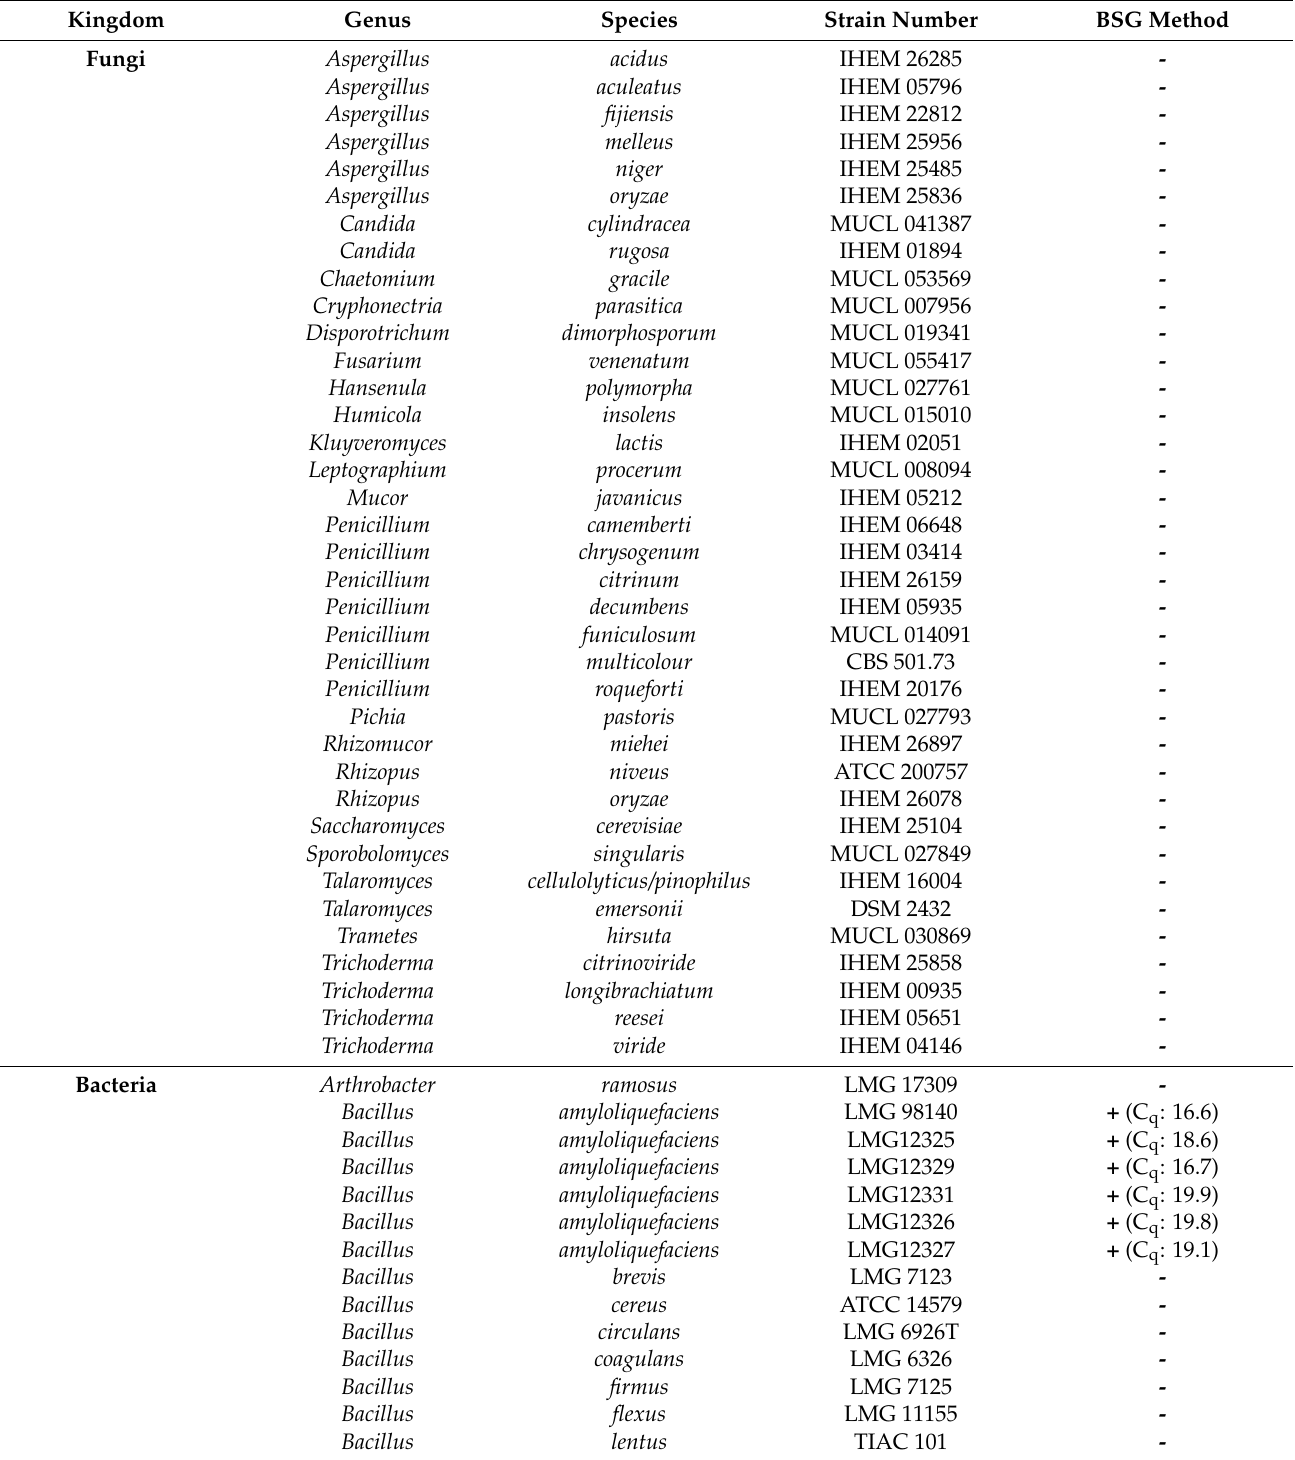
Table 2. Specificity assessment of the developed real-time PCR BSG method. The presence and absence of amplification are symbolized by “+” and “ − “, respectively. For each result, the experiment was carried out in triplicate on 10 ng of each sample. The means of the observed C q are indicated in